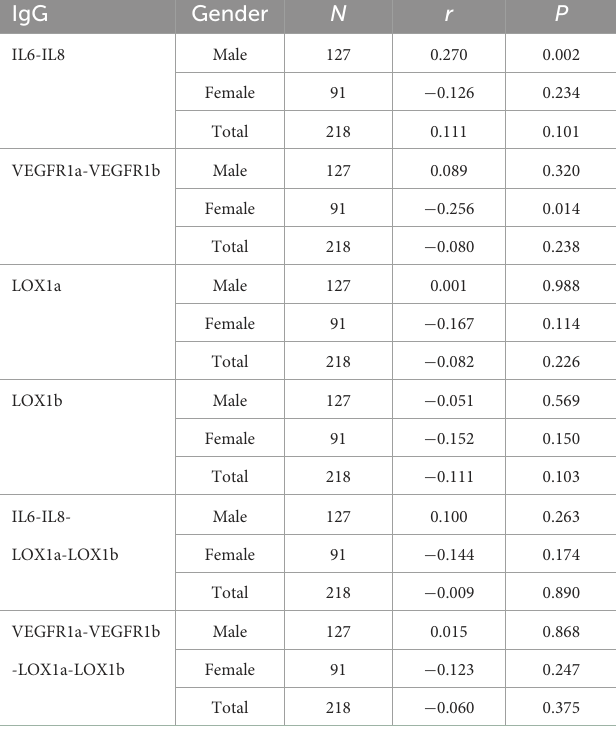
TABLE 5 Spearman correlation between plasma anti-peptide IgG levels and carotid plaque